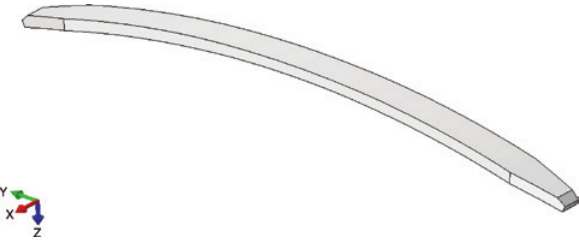
Figure 1: Solid model of the composite leaf spring.